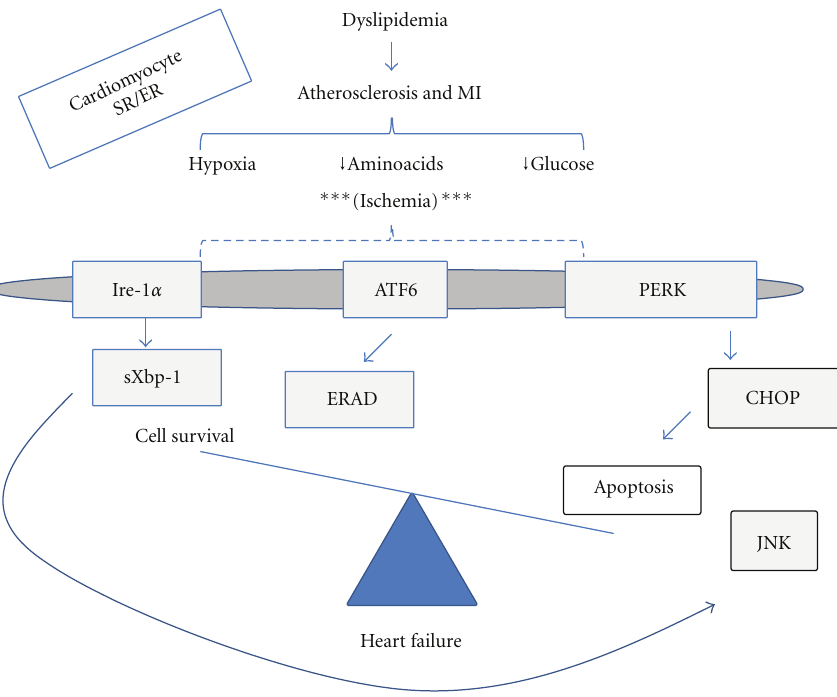
Figure 1: Working model of the cardiomyocyte unfolded protein response during ischemia. Activators of the UPR in cardiomyocytes at the sarcoplasmic reticulum (SR)/endoplasmic reticulu (ER) include ischemia during cardiovascular disease. Proximal e ff ectors of the UPR include IRE-1 α , ATF6, and PERK. IRE-1 α induces splicing of Xbp-1 mRNA and can promote prosurvival or proapoptotic pathways. ATF6 proteolysis leads to transcription of ER stress responsive genes and has been implicated in cardiomyocyte cell survival. Initial e ff ects of PERK include translational arrest that reduces the load on the SR/ER folding machinery. Downstream and distal e ff ector responses of PERK include CHOP, which promotes cardiomyocyte apoptosis and may contribute to heart